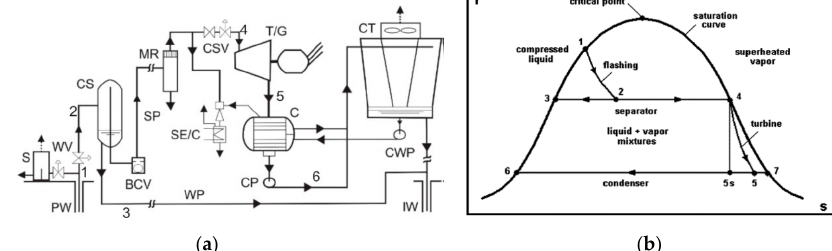
Figure 21. Single-flash geothermal system: ( a ) scheme of power plant; ( b ) T-s cycle diagram [51]. Energies 2020 , 13 , 3282